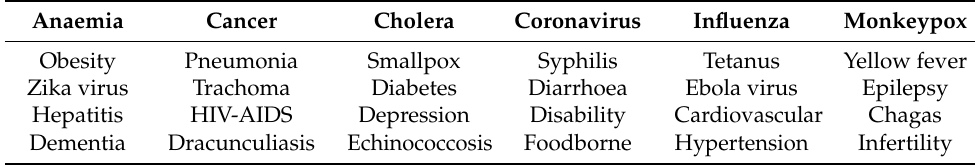
Table 3. Chosen diseases and conditions for collected